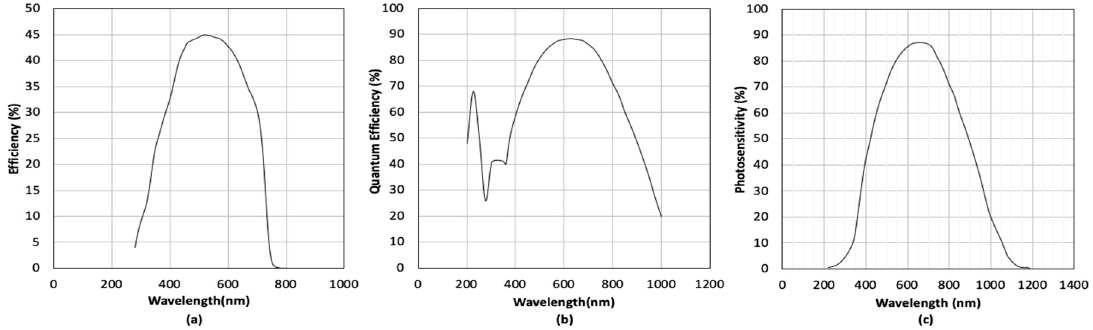
Figure 3. Typical optical detector performance curves: ( a ) example PMT efficiency curve, ( b ) example CCD quantum efficiency curve, and ( c ) example APD sensitivity curve.